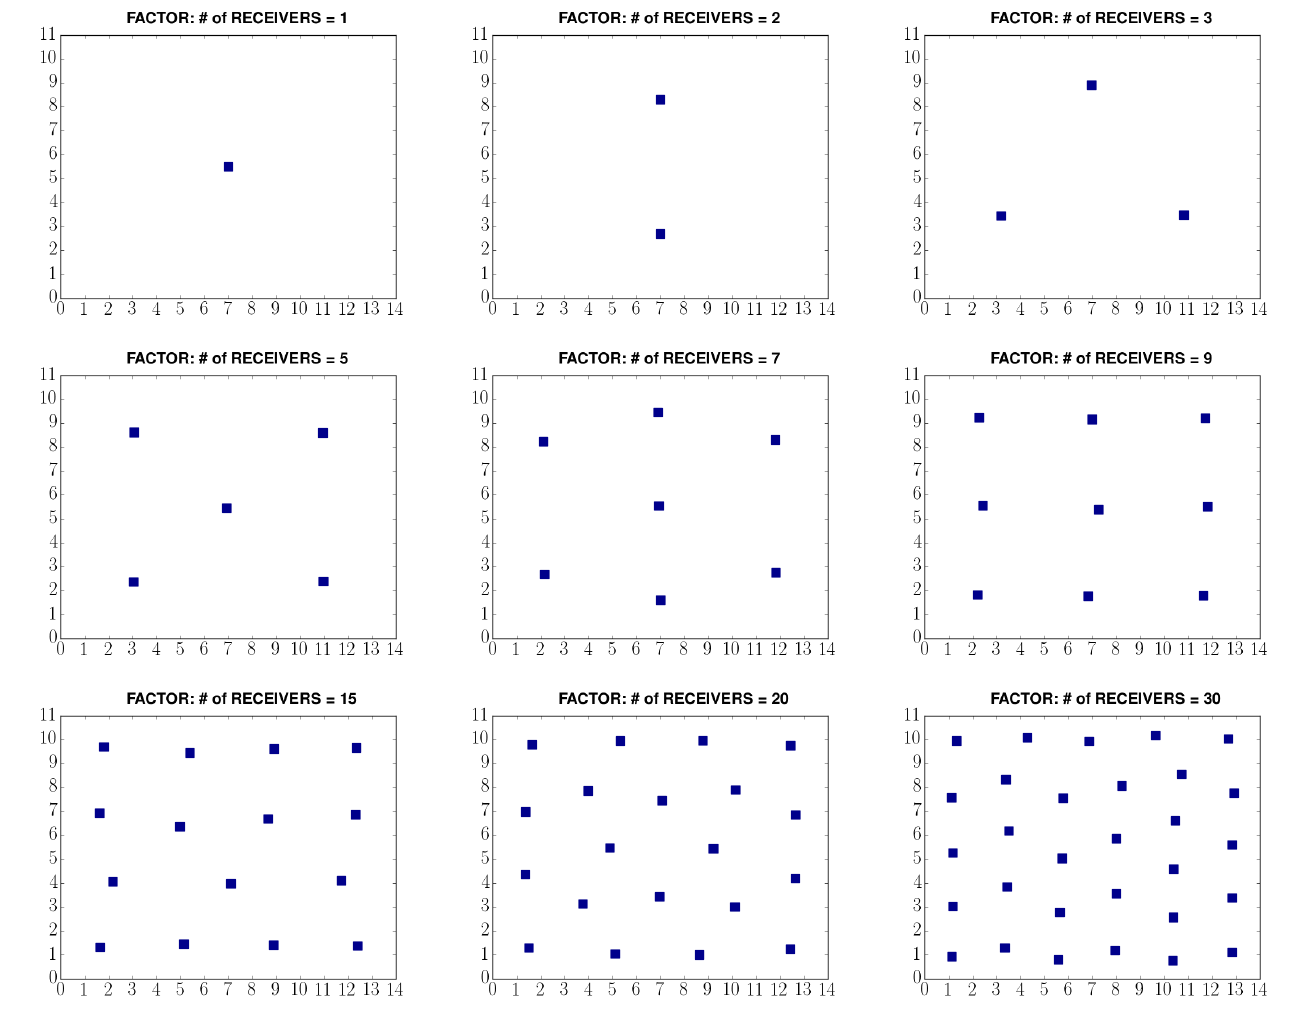
Figure 2. Sample output of k-means for placement of